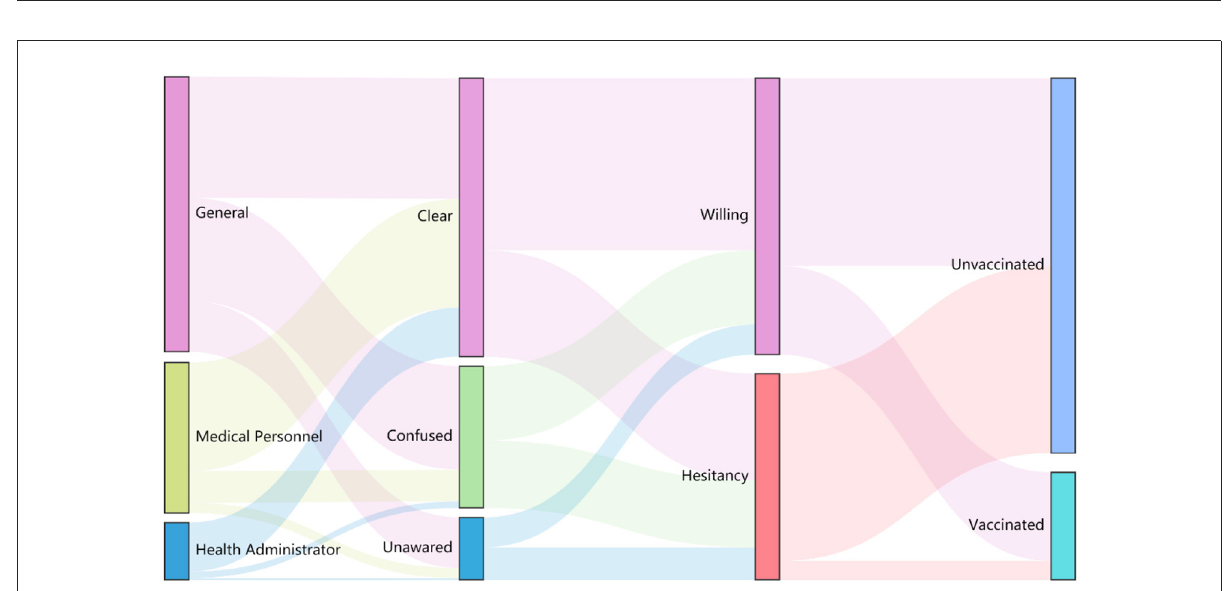
FIGURE2 Behavior pattern Sankey diagram showed leading nodes of vaccination rates among groups.